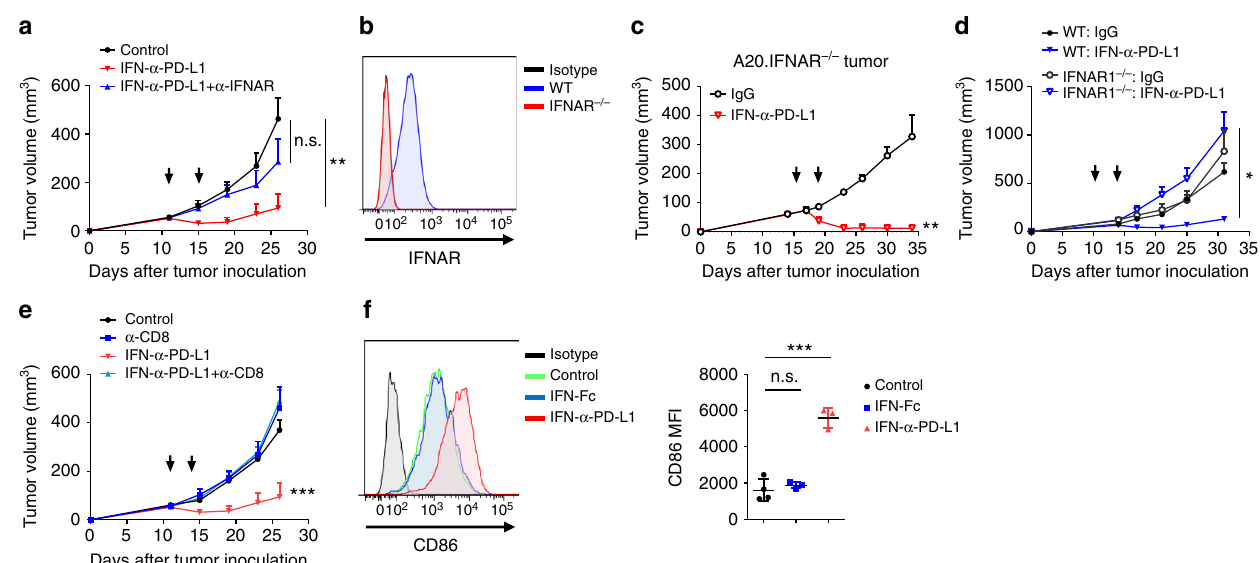
Fig. 5 IFNAR signaling in the host is essential for tumor control. a A20 tumor-bearing mice ( n = 5) were treated with IFN α -anti-PD-L1 on day 11. To block type I IFN signaling, 100 µ g of anti-IFNAR blocking antibody was injected i.t. into mice on days 11 and 14. b IFNAR expression in WT or IFNAR -/- A20 tumor cells in vivo (B220 + ) was evaluated by fl ow cytometry. c IFNAR -/- A20 tumor-bearing mice ( n = 6) were treated with IFN α -anti-PD-L1 on days 16 and 19. Tumor growth was measured twice per week. d WT or IFNAR1 -/- mice were inoculated with 5 × 10 5 MC38 cells. Mice ( n = 4 – 5) were treated with 25 µ g of IFN α -anti-PD-L1 on days 10 and 13. Tumor growth was measured twice per week. e MC38 tumor-bearing mice ( n = 5 – 6) were treated with IFN α -anti-PD- L1 on days 11 and 14. Anti-CD8 depletion antibody was administered on days 9, 12, and 16. Tumor growth was measured twice per week. f Two days after IFN α -anti-PD-L1 treatment, MC38 tumor tissues were isolated. Expression of CD86 in tumor-in fi ltrating DCs (CD11c + MHCII + ) was measured by fl ow cytometry. A representative graph is shown on the left, and MFI is shown on the right. Data indicate mean ± SEM and are representative of at least two independent experiments. * p < 0.05; ** p < 0.01; *** p < 0.001; n.s. not signi fi